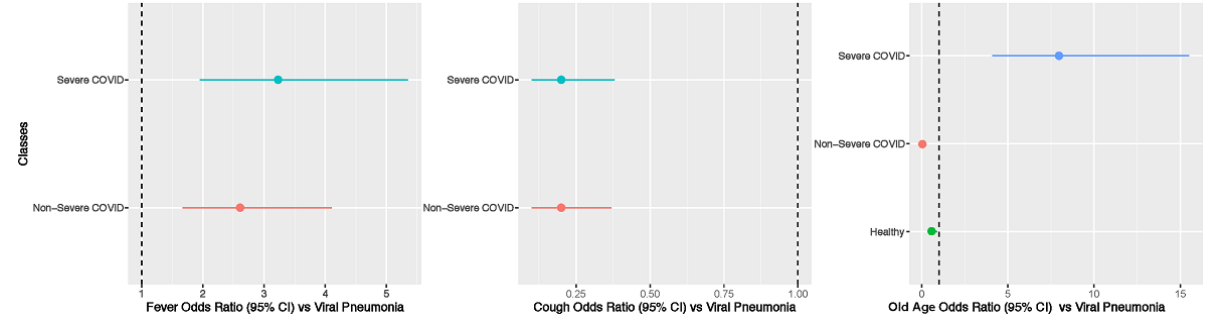
Figure 2. Forest plot of the top 3 differentiating clinical features. Viral pneumonia was used as the reference class during comparisons and the calculation of odds ratios. The noninfected healthy class had no individuals with fevers or coughs. Therefore, these individuals were not included in the first 2 graphs (ie, the left and middle graphs). The error bars represent variation in estimated odds ratios, not the original feature